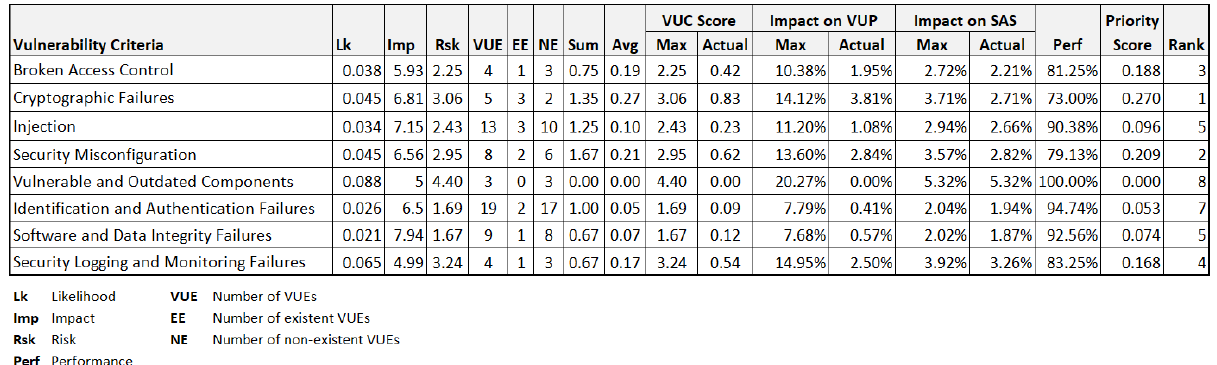
Figure 4. Security assurance scoreboard—security requirement metrics.